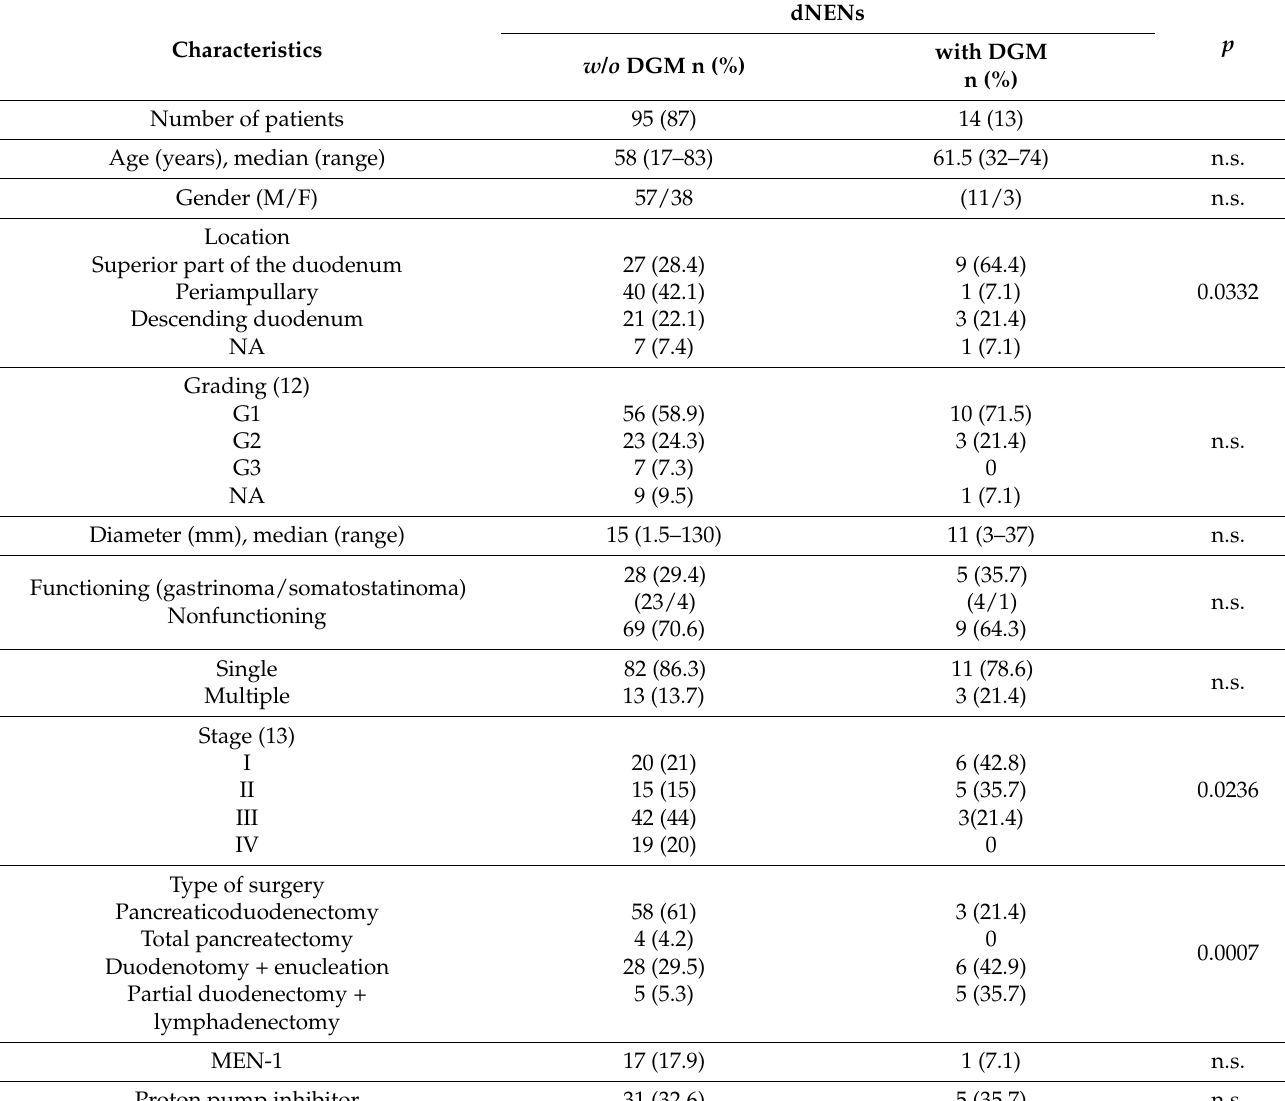
Table 1. Baseline characteristics of patients with duodenal gastric metaplasia (DGM) associated with duodenal neuroendocrine neoplasms (dNENs) compared to dNEN patients without